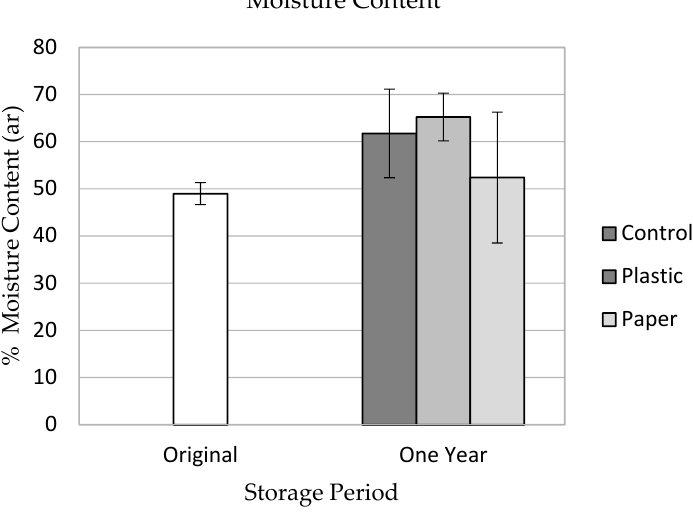
Figure 7. Change in moisture content of comminuted biomass after a storage period of one year.